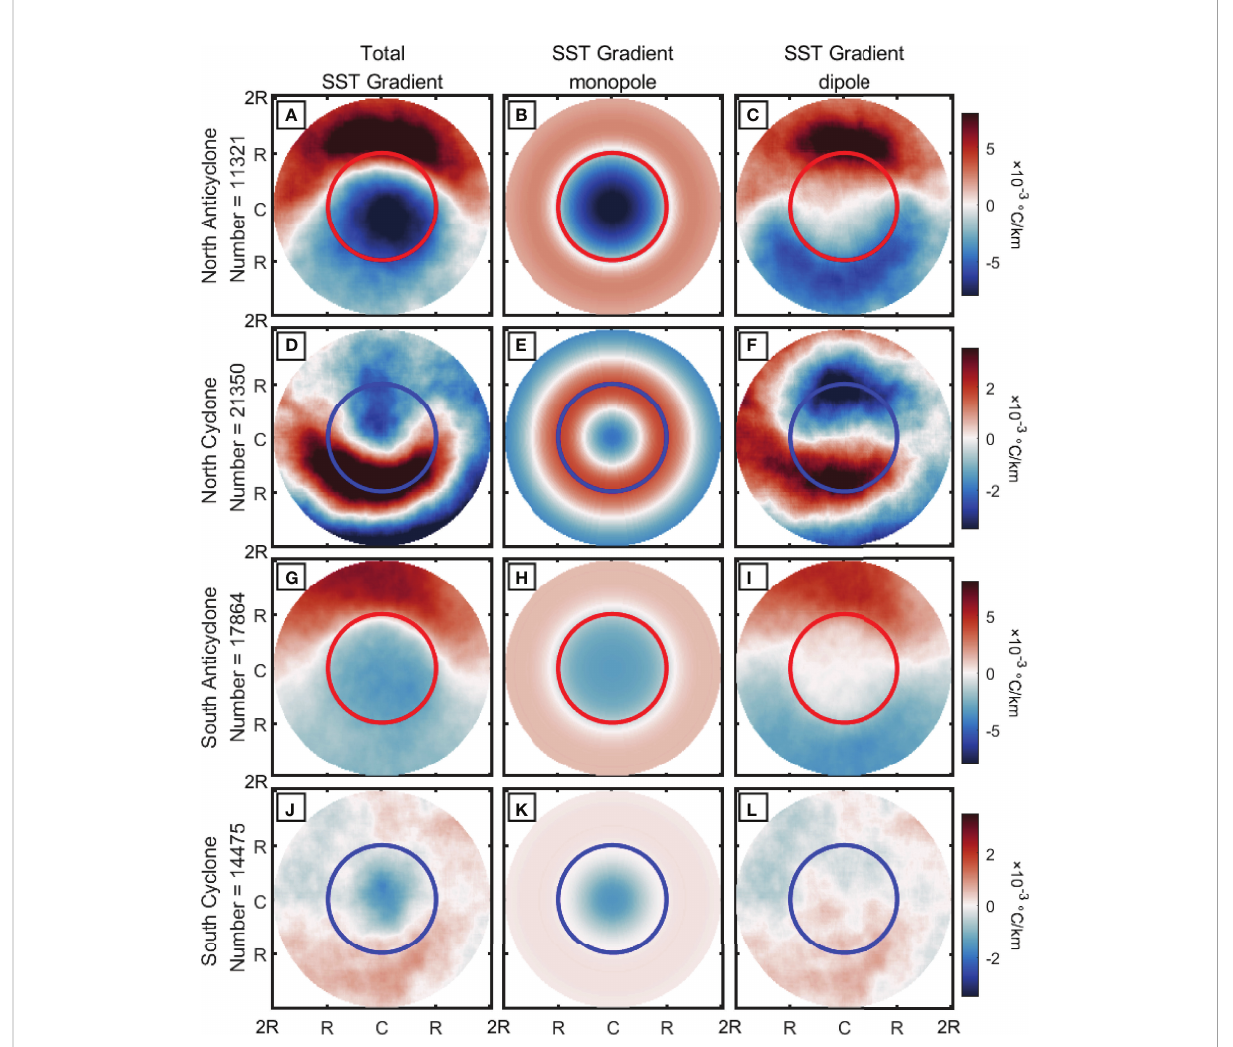
FIGURE 5 Composite of the SST gradient (×10 -3 °C/km) for (A – C and G – I) an anticyclone and (D – F and J – L) a cyclone in the (A – F) north and (G – L) south of the KE main path. The value within twice the radius is used for the composite, and the background fi eld is removed in advance. The second (B, E, H, and K) and third (C, F, I, and L) columns correspond to the monopole and dipole features, respectively. The red (blue) circles represent the peripheries of anticyclonic (cyclonic) eddies. The total number of eddies used for the composite is shown for each